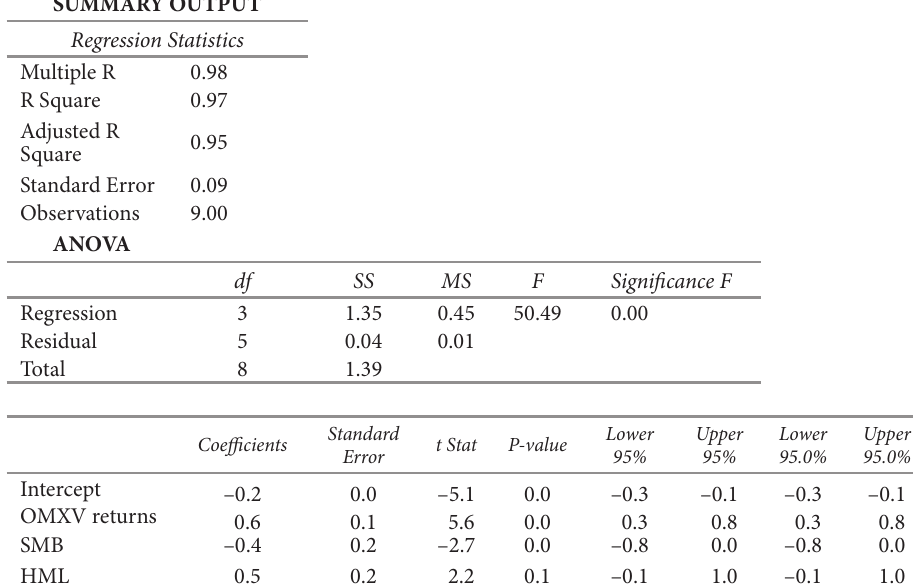
Table 5. Regression results for the Fama-French